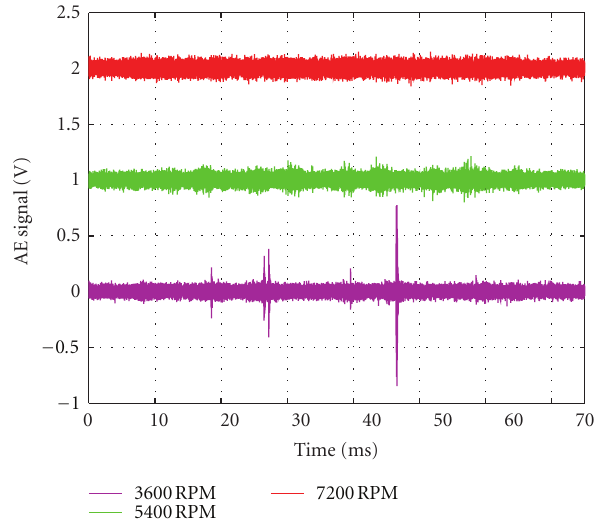
Figure 5: Touchdown signature for ABS-2 at di ff erent disk RPM (plots o ff set by 1V for